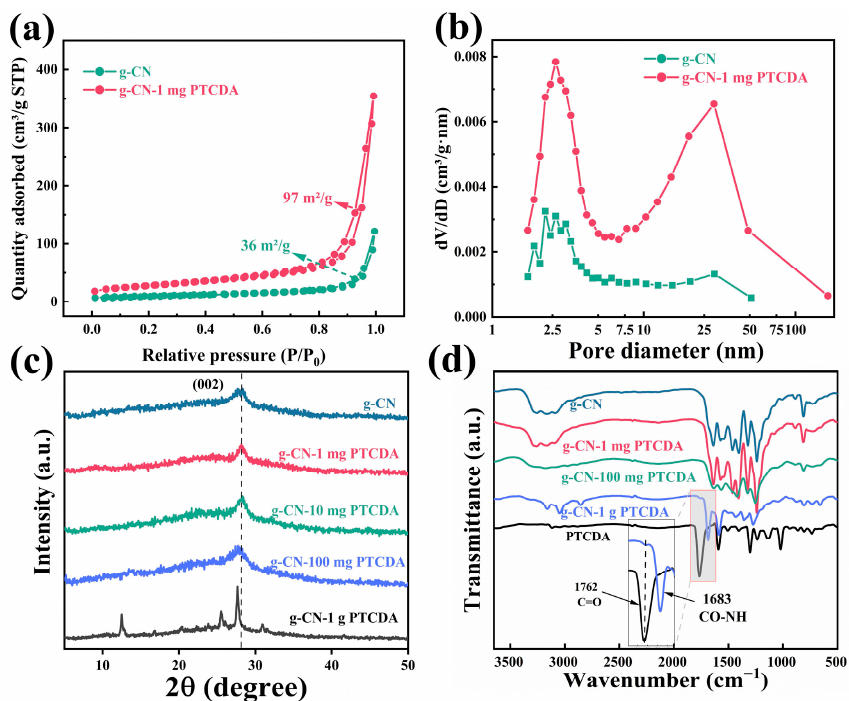
Figure 2. N 2 adsorption-desorption isotherms ( a ) and the corresponding pore size distribution curves ( b ) of g-CN and g-CN-1 mg PTCDA. XRD patterns ( c ), and FT-IR spectra ( d ) of the samples of g-CN and g-CN-x mg PTCDA ( x = 1, 10, 100, 1000).